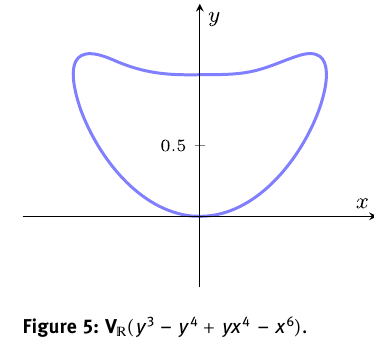
Figure 4: Figure 5: